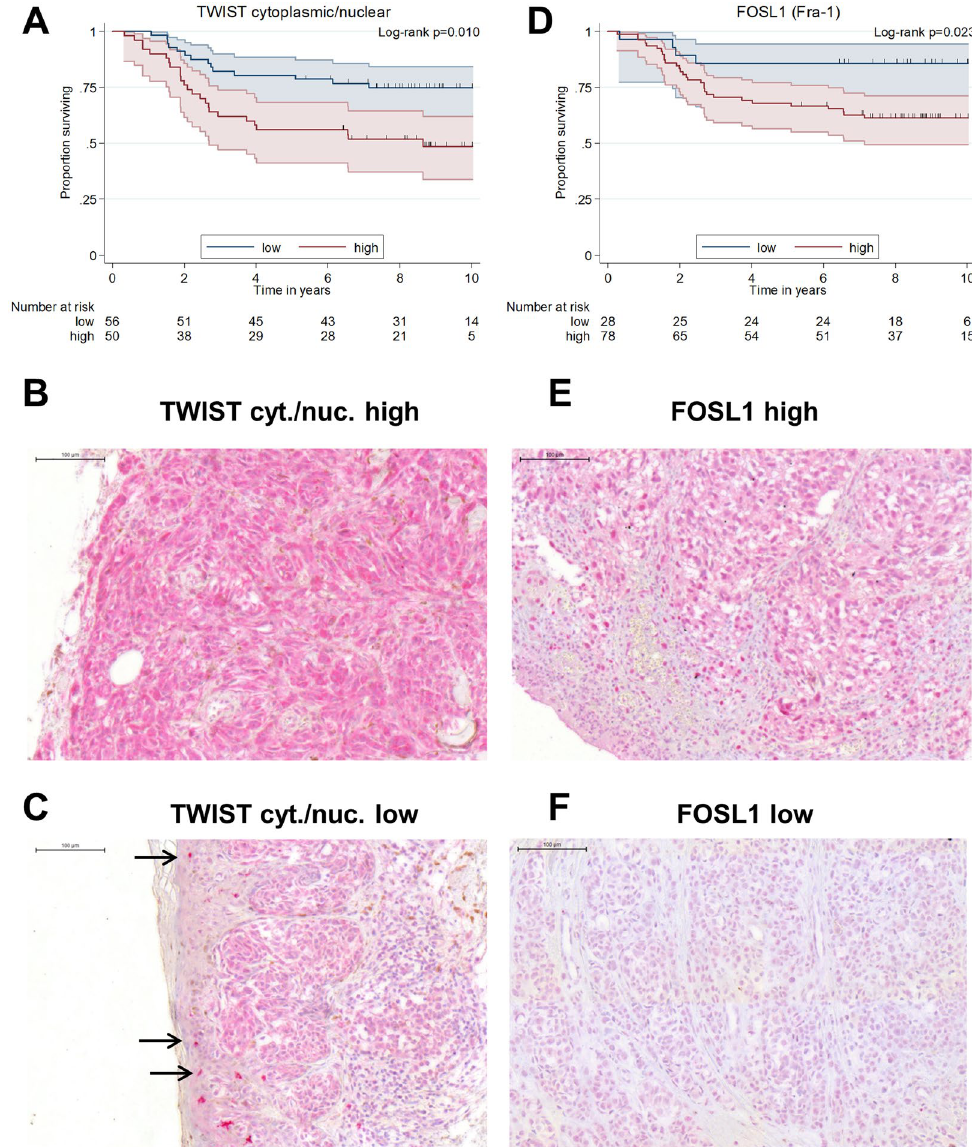
Figure 6. TWIST cytoplasmic/nuclear (cyt./nuc.) expression/location and FOSL1 (Fra-1) expression in human melanoma are correlated with patient survival. ( A ) Kaplan-Meier overall-survival analysis (OS): TWIST expression in melanoma samples was visualized by TWIST specific immunohistochemistry in melanoma samples from 106 patients. Patients were grouped as TWIST cyt./nuc. low (cyt./nuc. TWIST ≤ 2) or TWIST high (cyt./nuc. TWIST > 2). TWIST cyt./nuc. low ( ≤ 2) show a significantly longer overall survival than TWIST cyt./nuc. high ( > 2) patients (p = 0.010). ( B ) A melanoma with high TWIST cyt./nuc. expression: Immunohistochemical staining of paraffin embedded patient tissue for TWIST. ( C ) A melanoma with low TWIST cyt./nuc. expression: Immunohistochemical staining of paraffin embedded patient tissue for TWIST. Arrows indicate highly TWIST positive nuclei in normal skin epidermis. ( D ) Kaplan-Meier overall-survival analysis (OS): FOSL1 expression in melanoma samples was visualized by FOSL1 specific immunohistochemistry in melanoma samples from 106 patients. Patients were grouped as FOSL1 0–1 (no or low FOSL staining) or FOSL1 2–3 (medium or high FOSL1 staining). FOSL1 low patients show a significantly longer overall survival than FOSL high patients (p = 0.023). ( E ) A melanoma with high FOSL1 expression: Immunohistochemical staining of paraffin embedded patient tissue for FOSL1. ( F ) A melanoma with low FOSL1 expression: Immunohistochemical staining of paraffin embedded patient tissue for interplay of CEACAM1 which was also indicated by the whole genome expression array analysis (703 significantly regulated genes including IGFBP7, LXN and TWIST). CEACAM1 association with short survival was reflected in our xenograft model of primary tumor growth and spontaneous metastasis in which both were significantly reduced by CEACAM1 knockdown increasing the animals’ survival. To our knowledge this is the first direct in vivo demonstration in a spontaneous metastasis model that CEACAM1 is functionally involved in melanoma metastasis